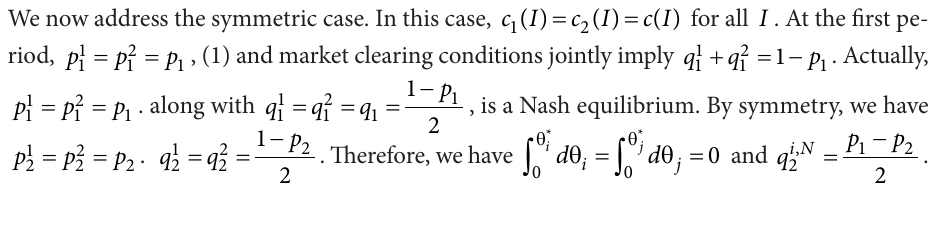
Table 1. A comparison innovation between private firms (high efficiency firms) and state-owned enter- prises (SOEs). The tabulated number is the average patent stock in five years. For simplify, firms refer to privatization ones in recent years in China SOEs Private firms Difference Innovation and utility 0.416 patent stock